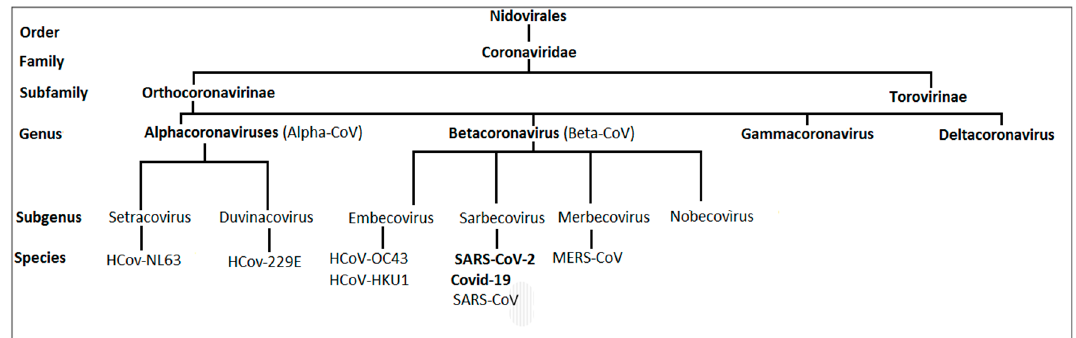
Figure 1. The classification of coronaviruses in realm Riboviria, kingdom Orthornavirae, phylum Pisuviricota, order Nidovirales, suborder Cornidovirineae, family Coronaviridae, and two subfamilies Orthocoronavirinae, is divided into four genera: Alphacoronavirus , Betacoronavirus , Gammacoronavirus, and Deltacoronavirus . Human coronavirus OC43 (HCoV-OC43), human coronavirus HKU1 (HCoV-HKU1), SARS-CoV-2, severe acute respiratory syndrome coronavirus (SARS-CoV), and Middle Eastern respiratory coronavirus (MERS-CoV) are Betacoronaviruses . human coronavirus NL63 (HCoV-NL63) and human coronavirus (HCoV-229) are Alphacoronaviruses.